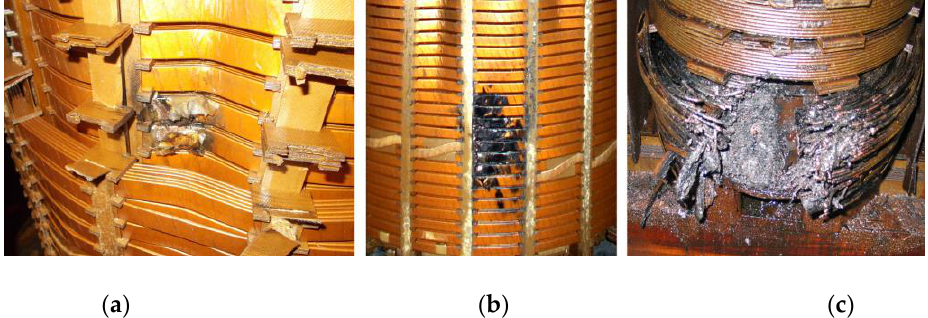
Figure 6. Possible reasons for interturn discharges in power transformer: ( a ) high electrically stress areas in wedge-shaped oil gaps and ( b ) too small insulation spacing caused by excessive axial deflection of conductors (coils).